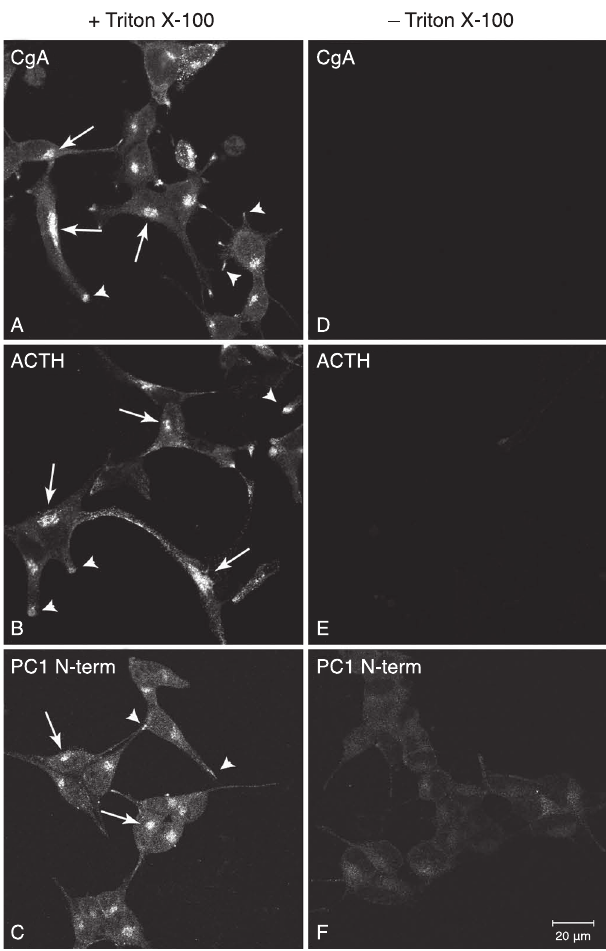
Figure 4. Immunocytochemical analysis of cytosolic proteins in AtT20 cells. AtT20 cells were chemically fixed with 2% PFA/PBS and then treated with and without the detergent, Triton X-100. Three cytosolic proteins (p115, Grasp65 and N-terminus of the transferrin receptor) were stained by indirect immunofluorescence. For p115 ( A , D ) and Grasp65 ( B , E ), staining of the Golgi area was observed and for the transferrin receptor ( C , F ), staining of the plasma membrane/endosomes were observed, whether the cells were treated with Triton X-100 or not. This demonstrated that the antibodies had access to the cytosol even with only PFA fixation. Bar 20 m